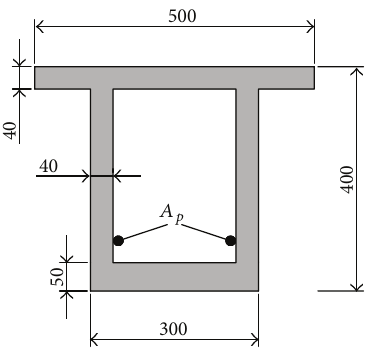
Figure 4: Geometric properties of the box section used in the numerical example